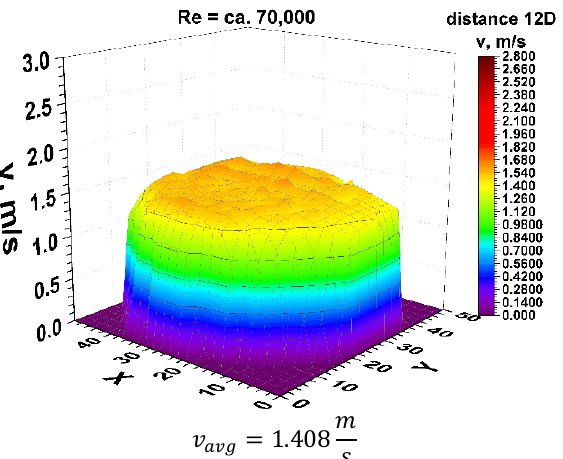
Figure 21. Velocity block at the distance 12D from the disturbance obtained by means of LDA measurements for Re ≅ 70,000.